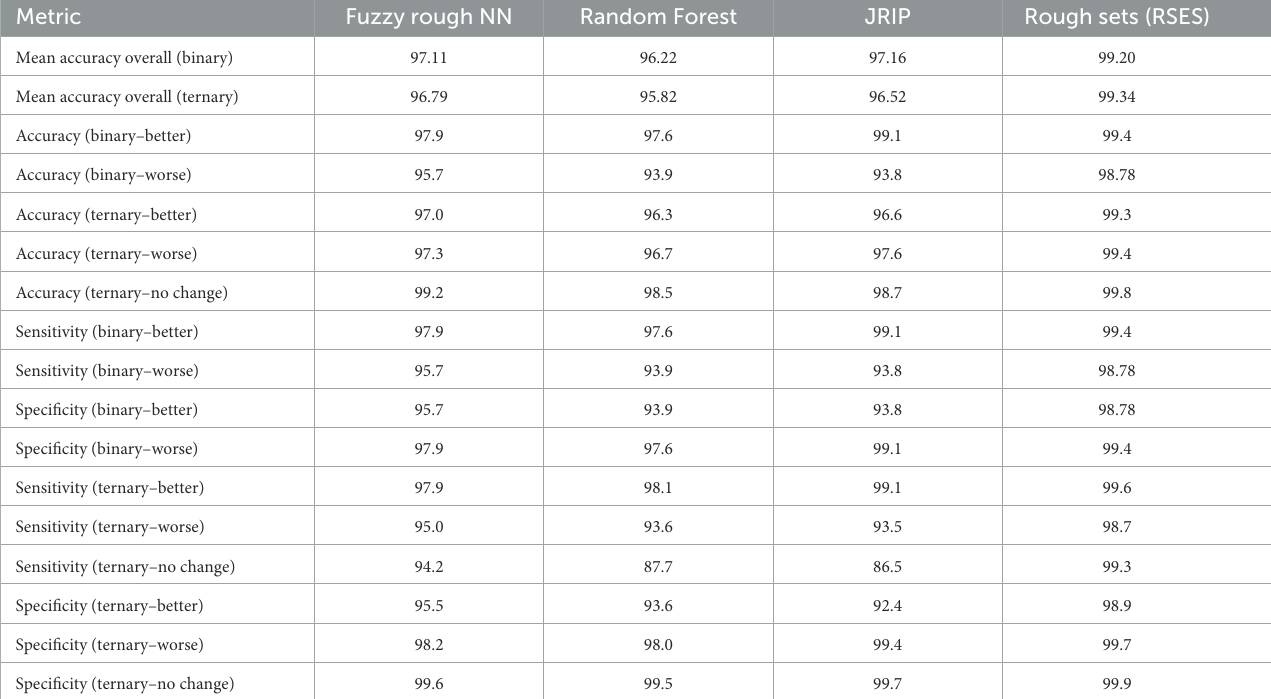
TABLE 1 Results—binary and ternary class experiments.